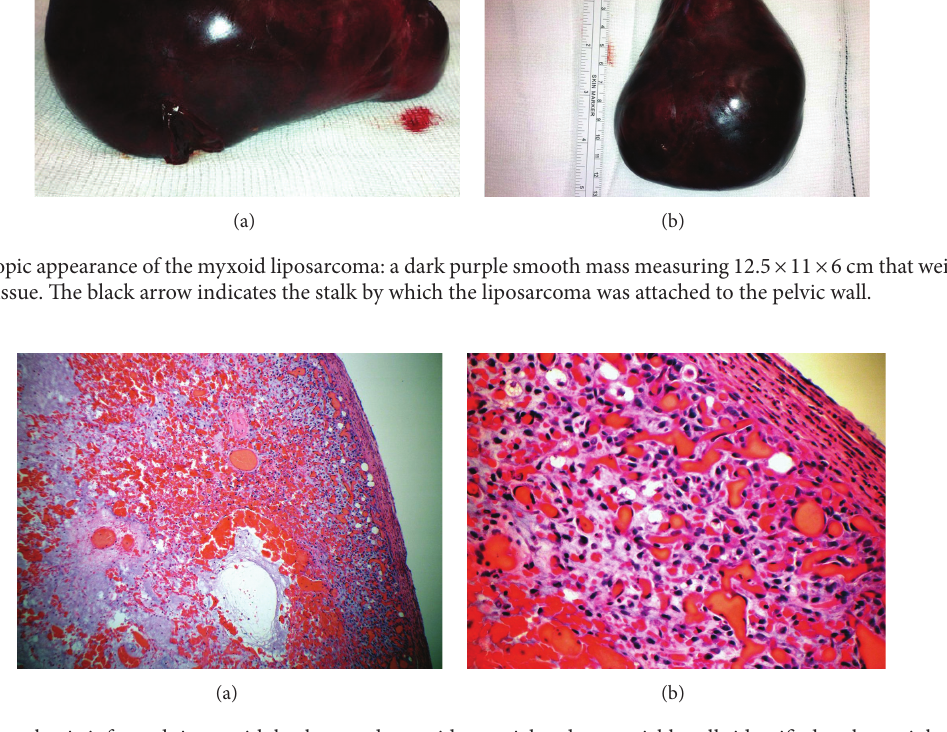
Figure 2: (a) Haemorrhagic infarcted tissue with background myxoid material and some viable cells identified at the periphery (haematox- ylin-eosin, 10x). (b) Both lipoblasts and round cells at the periphery of the tumour (haematoxylin-eosin, 40x).